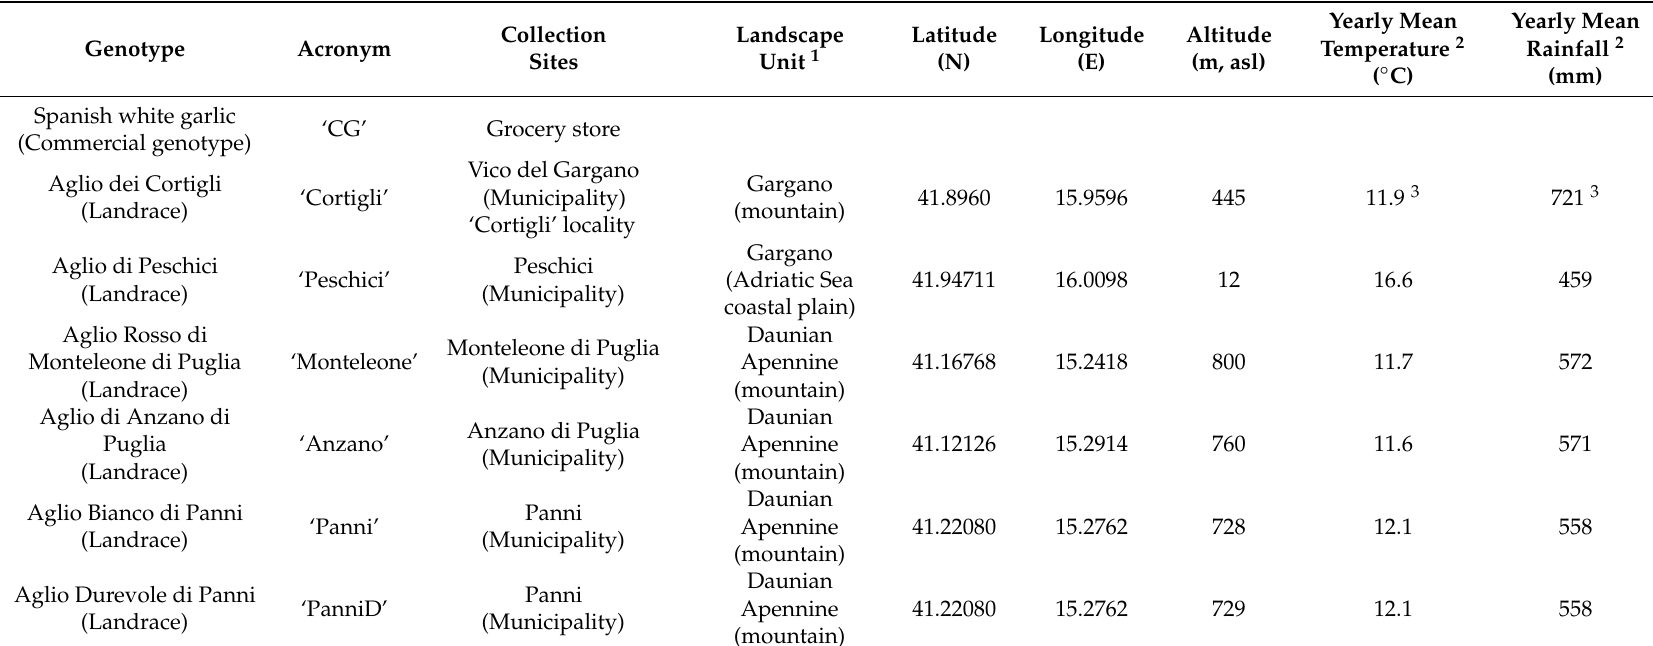
Table 1. List of garlic genotypes and description of collecting